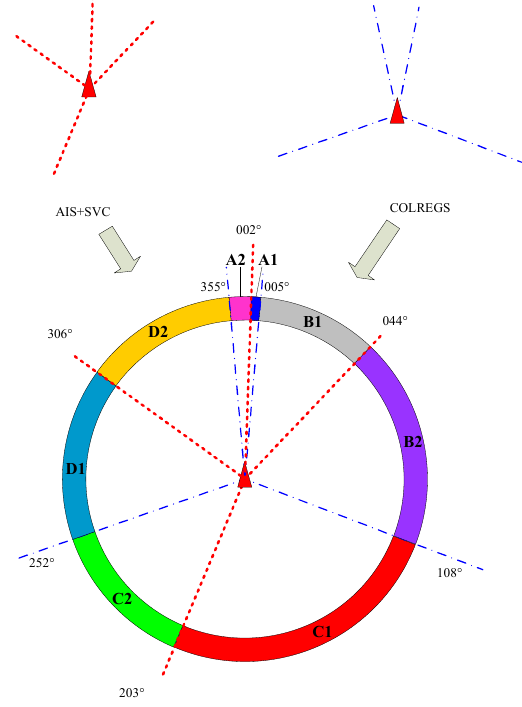
Figure 4. Ship’s encounter azimuthal map.